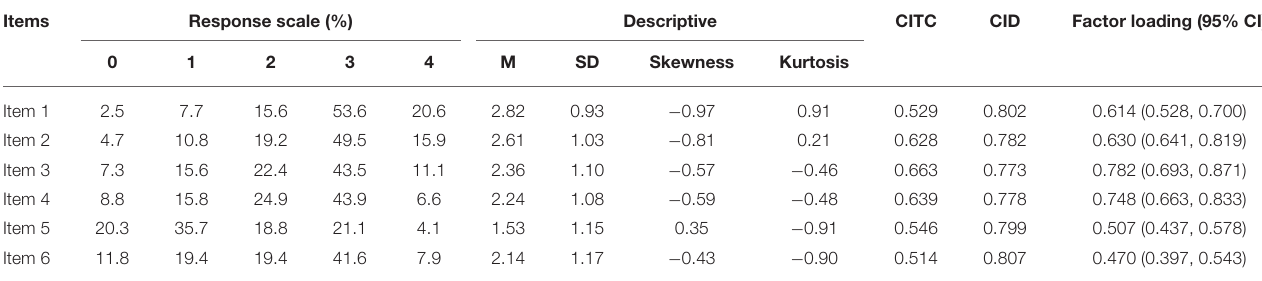
TABLE 2 | Item properties of the SAVE-6 scale among cancer patients.